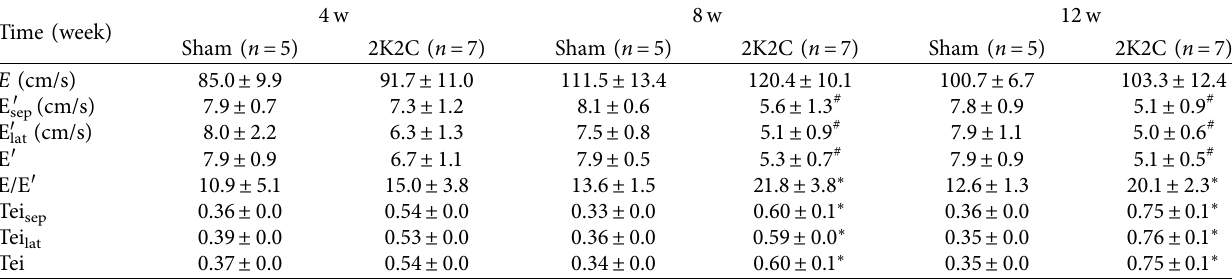
lateral of mitral annular; Tei, the average of Tei sep and Tei lat . Data are presented as the mean ± standard deviations from each group. # is P < 0 . 01 and ∗ is P < 0 . 05.